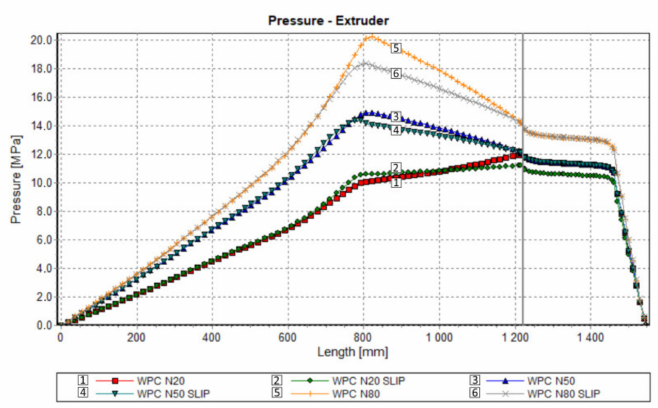
Figure 12. Process simulation: Pressure profile.